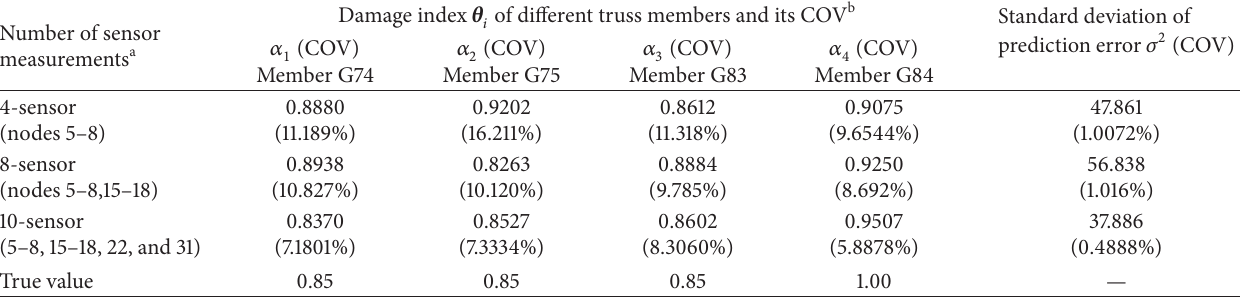
Table 4: Identified damages based on model class M3 with three measurement